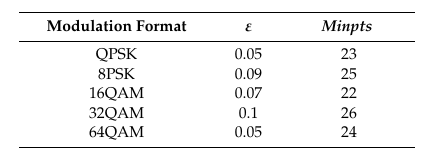
Table 1. Neighborhood parameters of five di ff erent MFs.